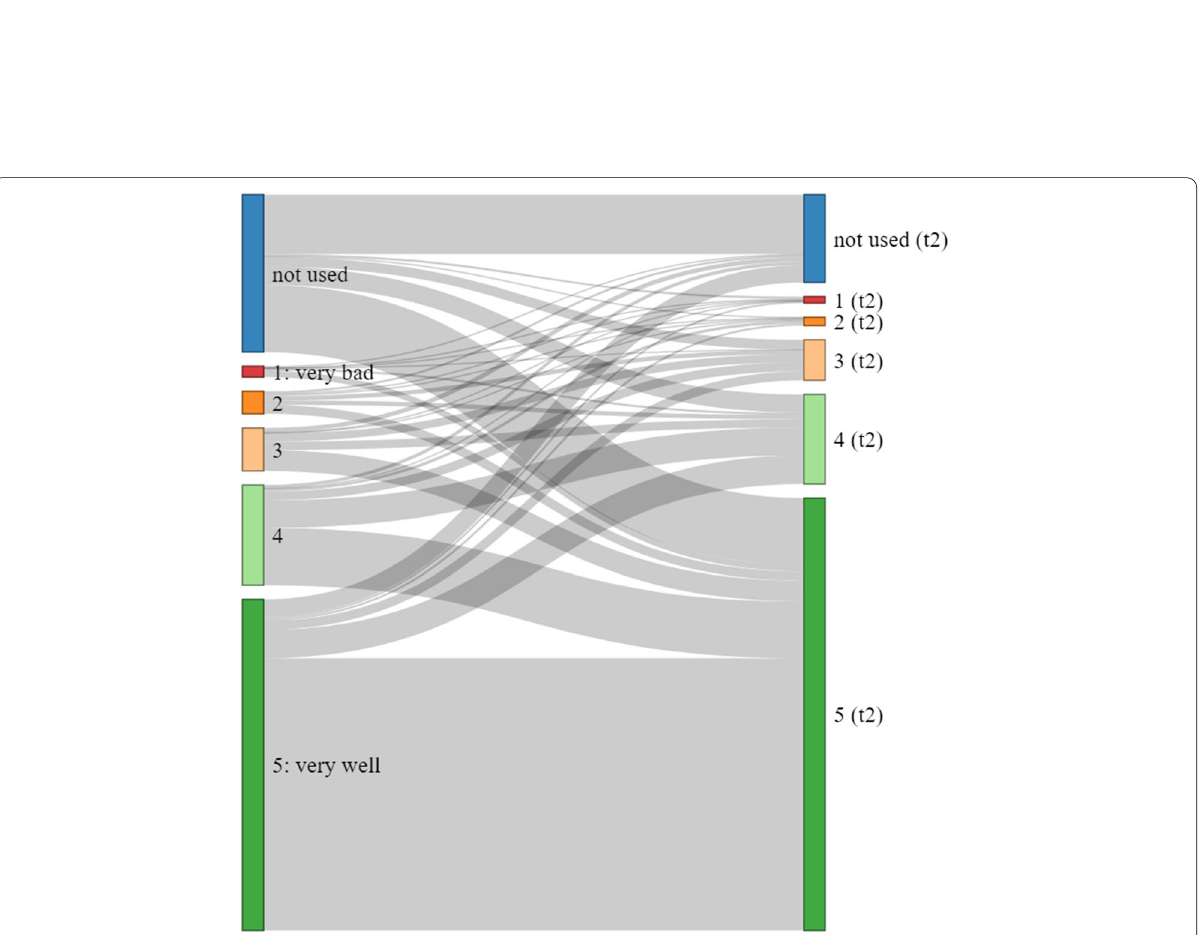
Fig. 3 Extent of implementation of group separation indoors as reported by directors. Legend: changes in answers between first and second point of measurement, CKS-Survey